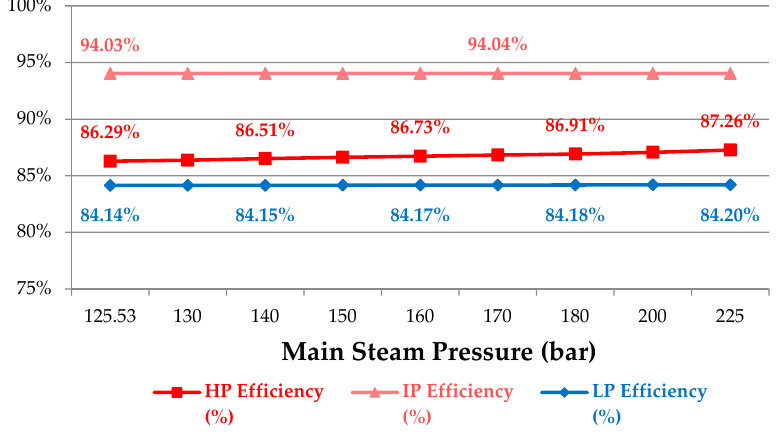
Figure 6. Effect of the main steam pressure on turbine stage efficiency.